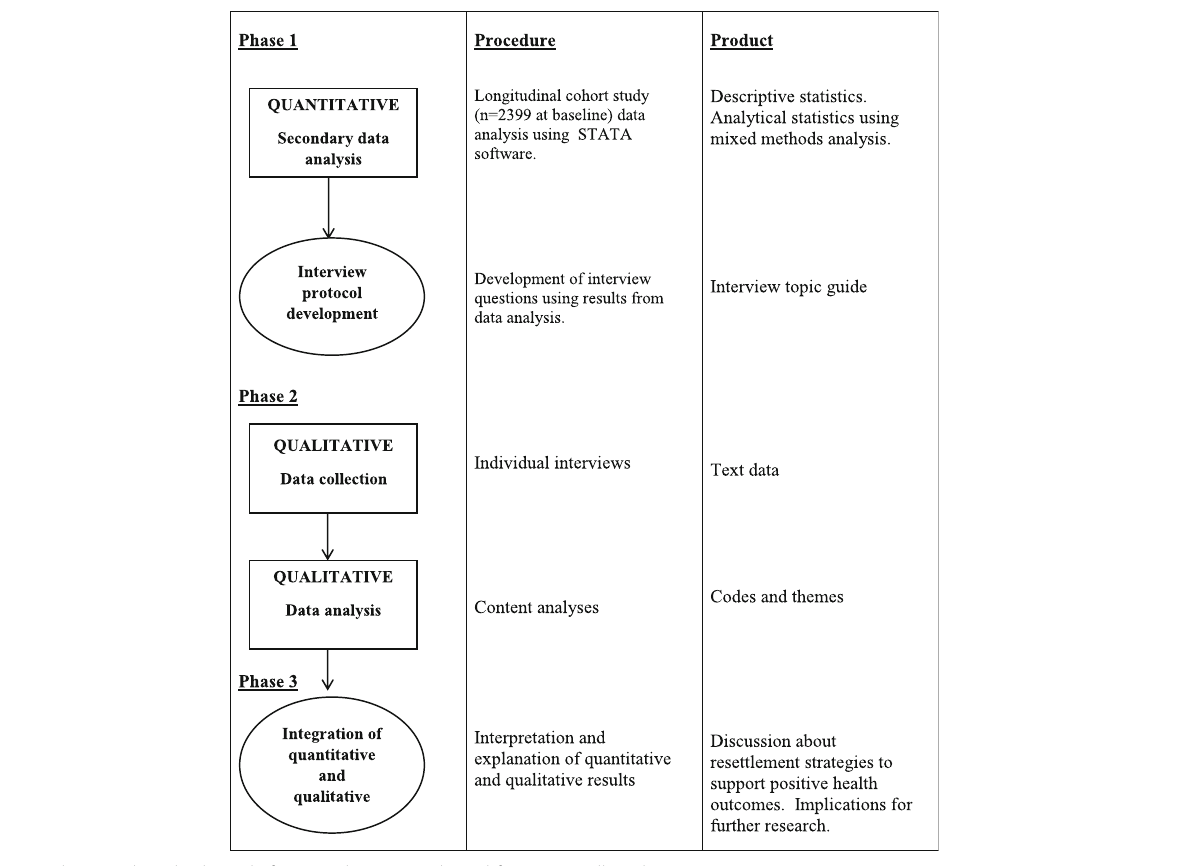
Fig. 1 The mixed methods study framework. (Figure adapted from Creswell et al., 2003)